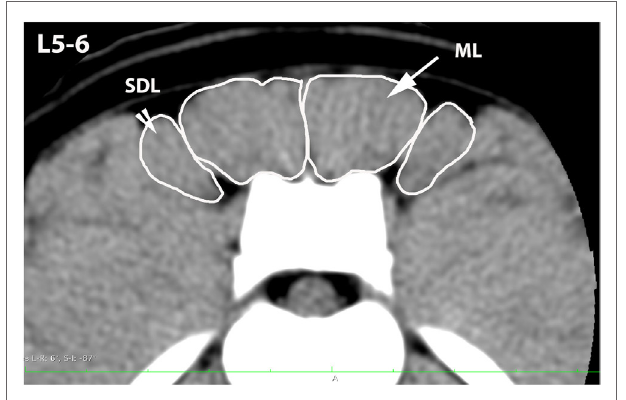
FIGURe 3 | transverse Ct image at the level of L5–6, illustrating margins of the multifidus lumborum (ML) and sacrocaudalis dorsalis lateralis (sdL) .